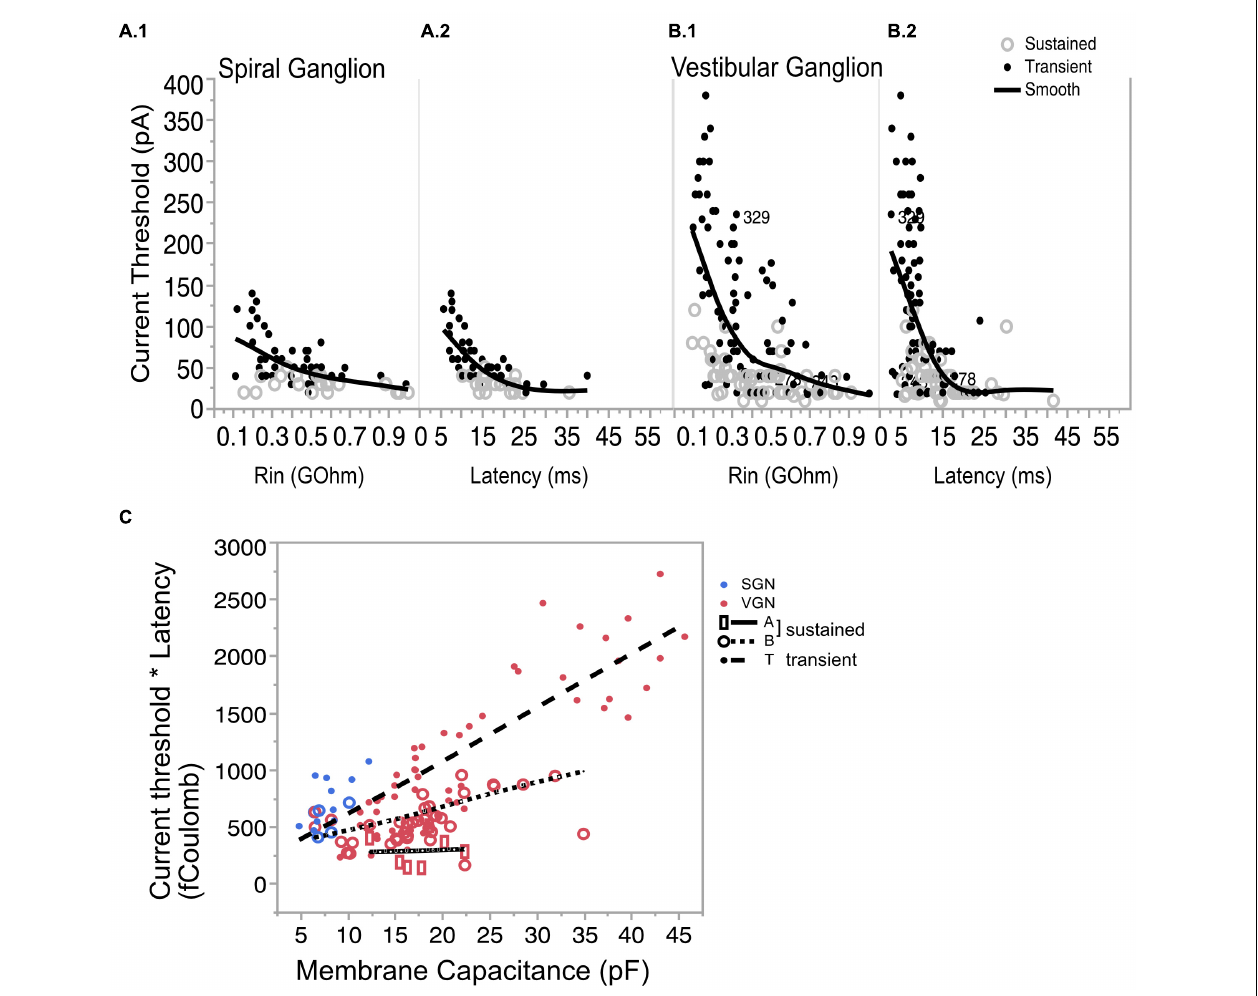
FIGURE 7 | Covariation of current threshold and first-spike latency. (A.1) Current threshold decreases with input resistance for sustained- and transient-spiking neurons in SGN. (A.2) Current threshold as a function of response latency showing that cells with large thresholds are also the cells with short latencies. (B.1,B.2) Same as (A.1,A.2) but for VGN. Solid lines in (A.1,A.2,B1,B.2) are smoothed spline curves drawn through the pooled transient- and sustained-spiking groups. (C) Charge ( Q ) that is required to reach action-potential peak plotted as a function of membrane capacitance. Q is estimated by multiplying (*) the current threshold by the first-spike latency. Symbols with regression lines indicate transient-spiking (dots/dash line), sustained-B spiking (open circles/dotted line) and sustained-A spiking (open rectangles/solid line). Spiral ganglion neurons are indicated in blue symbols and vestibular ganglion neurons are indicated by red symbols. * indicated multiplication of the two